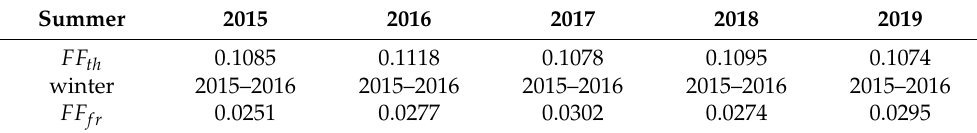
Table 1. FF fr and FF th from SMAP’s algorithm at Xilinhot site.